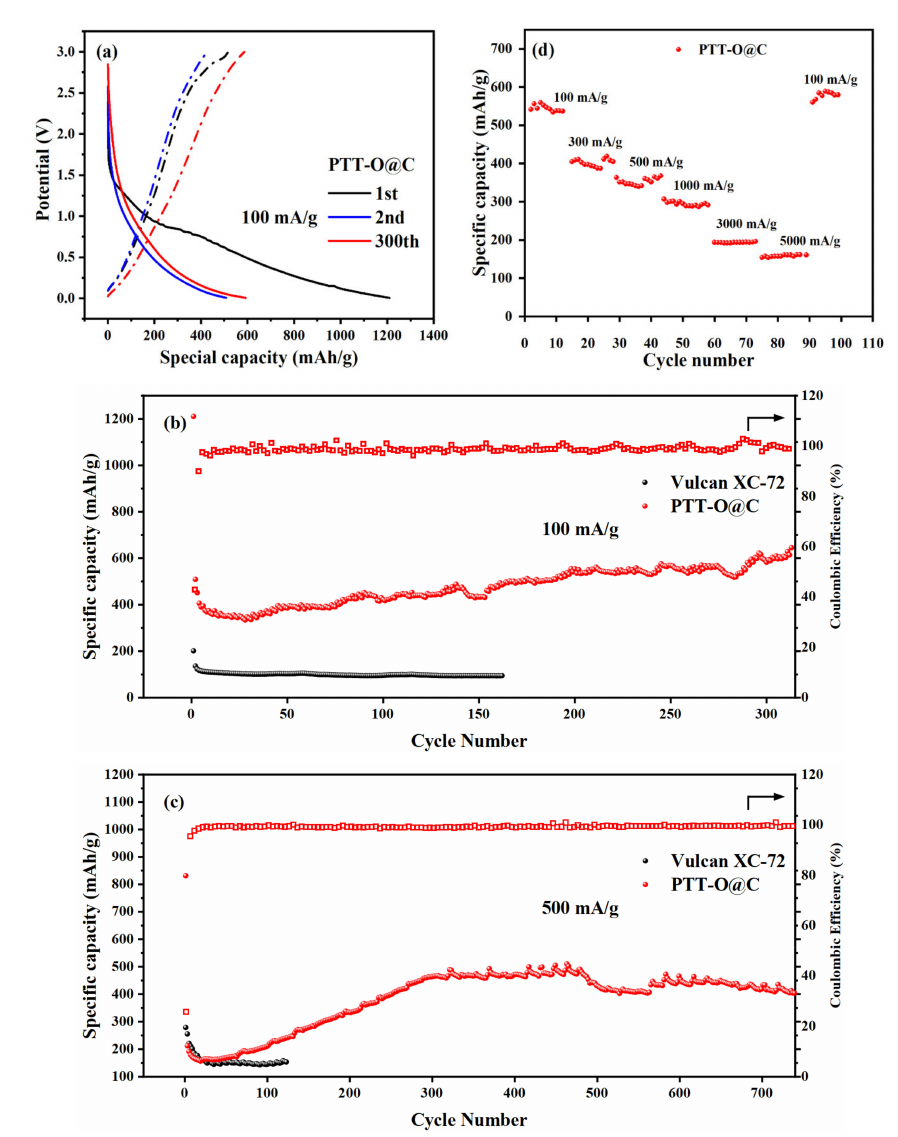
Figure 9. ( a ) The GDC curve of PTT-O@C; ( b ) the cycling performances of PTT-O@C at 100 mA g − 1 , the solid red ball represents the specific capacity of PTT-O@C, and the black ball represents the specific capacity of Vulcan XC-72, the hollow box with red color represents coulombic efficiency (%) of the PTT-O@C; ( c ) the cycling performances of PTT-O@C at 500 mA g − 1 , the solid red ball represents the specific capacity of PTT-O@C, and the black ball represents the specific capacity of Vulcan XC-72, the hollow box with red color represents coulombic efficiency (%) of the PTT-O@C; ( d ) the rate performance of